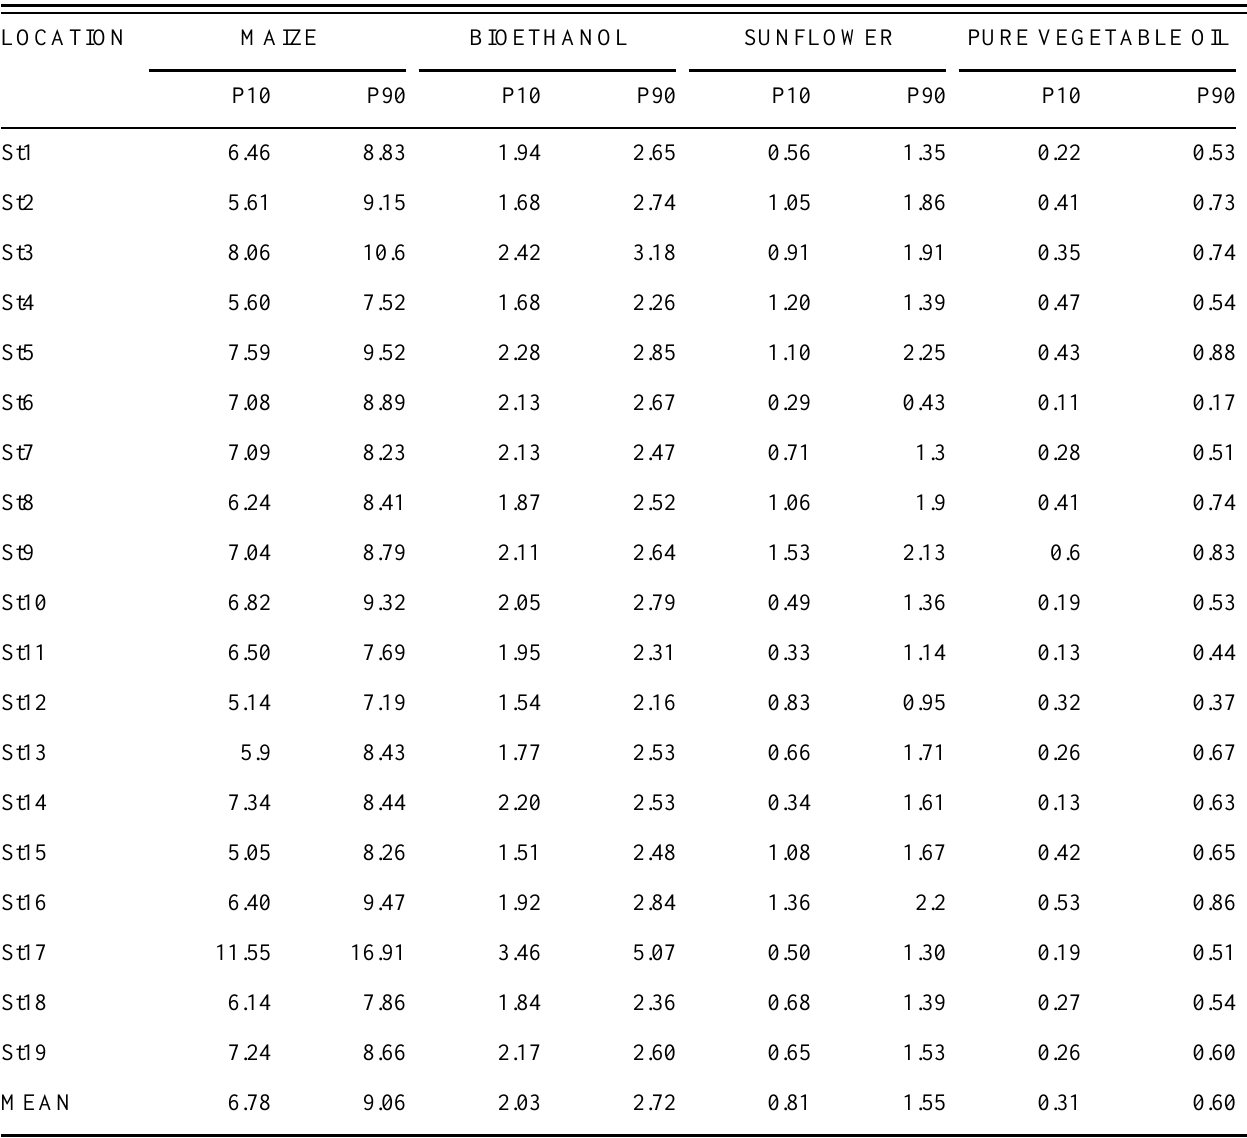
Table 4. Maize and sunflower productivity (ton/ha) simulated with meteorological data of the 19 weather stations in Tuscany, and potential bioethanol and pure vegetable oil obtainable (ton/ha), respectively. Legend: P10 = 10th percentile; P90 = 90th